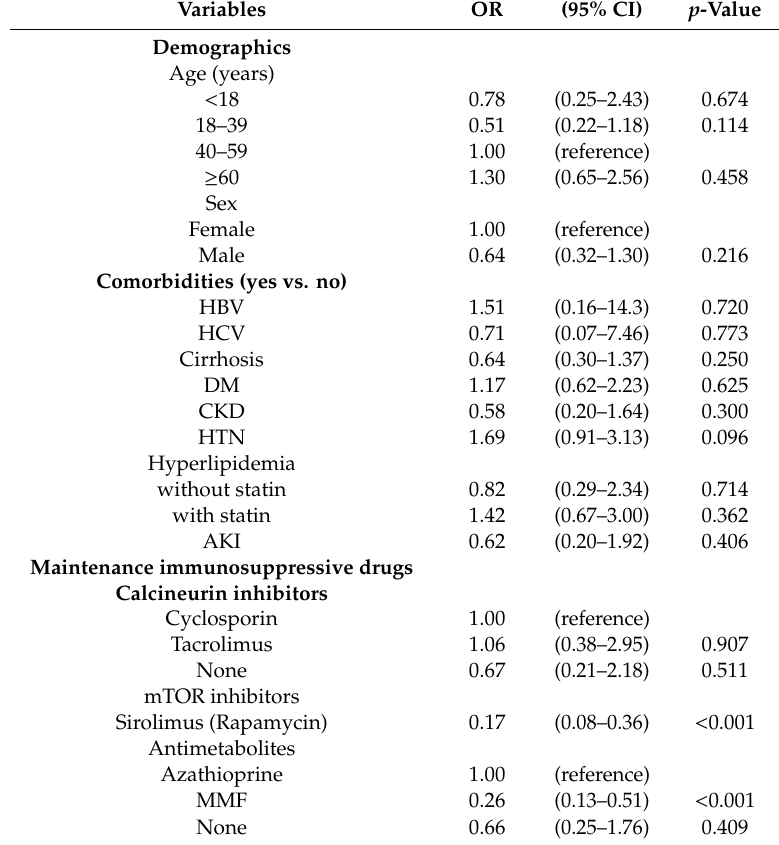
Table 6. Multivariate logistic regression analysis of risk factors associated with late dialysis (non-dialysis vs. late